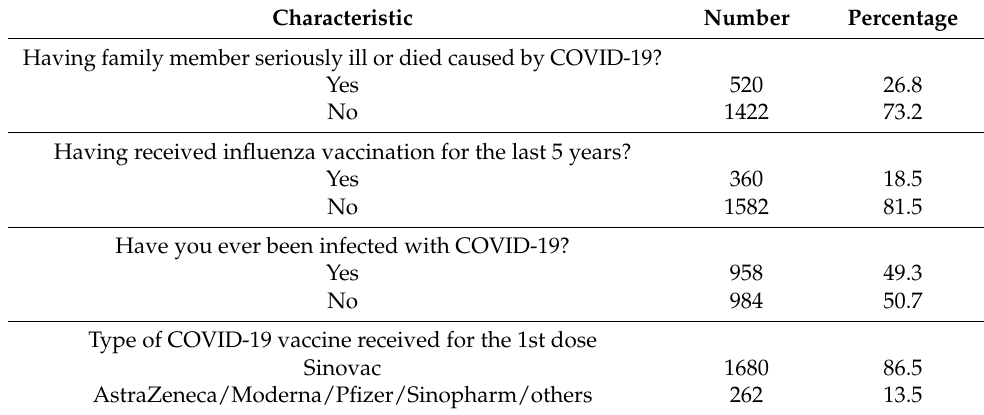
Table 3. Factors of WTP of booster dose of COVID-19 vaccine in Indonesia ( n = 1942). Characteristic Number Percentage Having family member seriously ill or died caused by